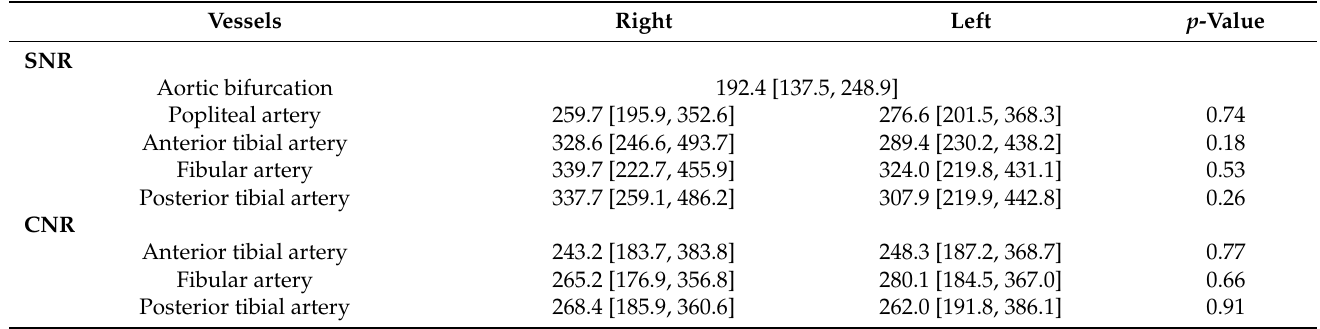
Table 2. Signal-to-noise ratio (SNR) and contrast-to-noise ratio (CNR) determined in different vessels. The values are given as the median with the interquartile range (IQR); p -values were determined using the Wilcoxon signed-rank